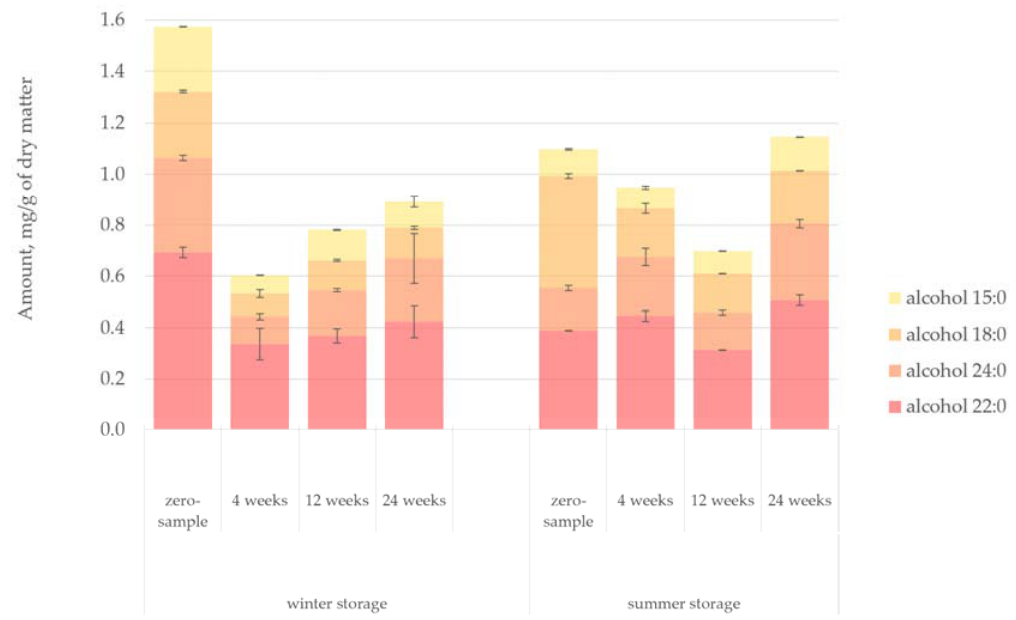
Figure 10. Changes in fatty alcohols during summer and winter storage periods of saw log bark.